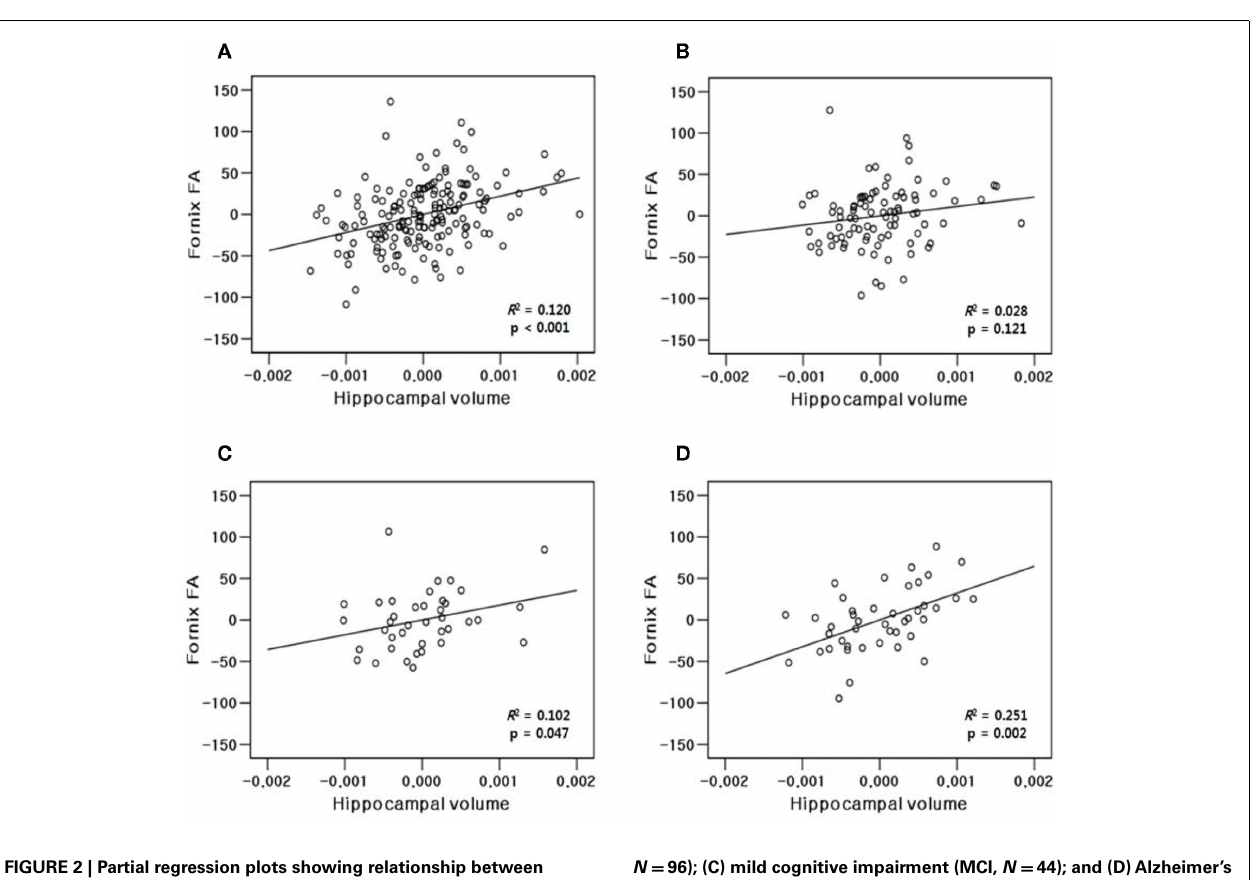
FIGURE 2 | Partial regression plots showing relationship between fractional anisotropy of the fornix and volume of the hippocampus within (A) all study subjects ( N = 184); (B) cognitively normal (CN,